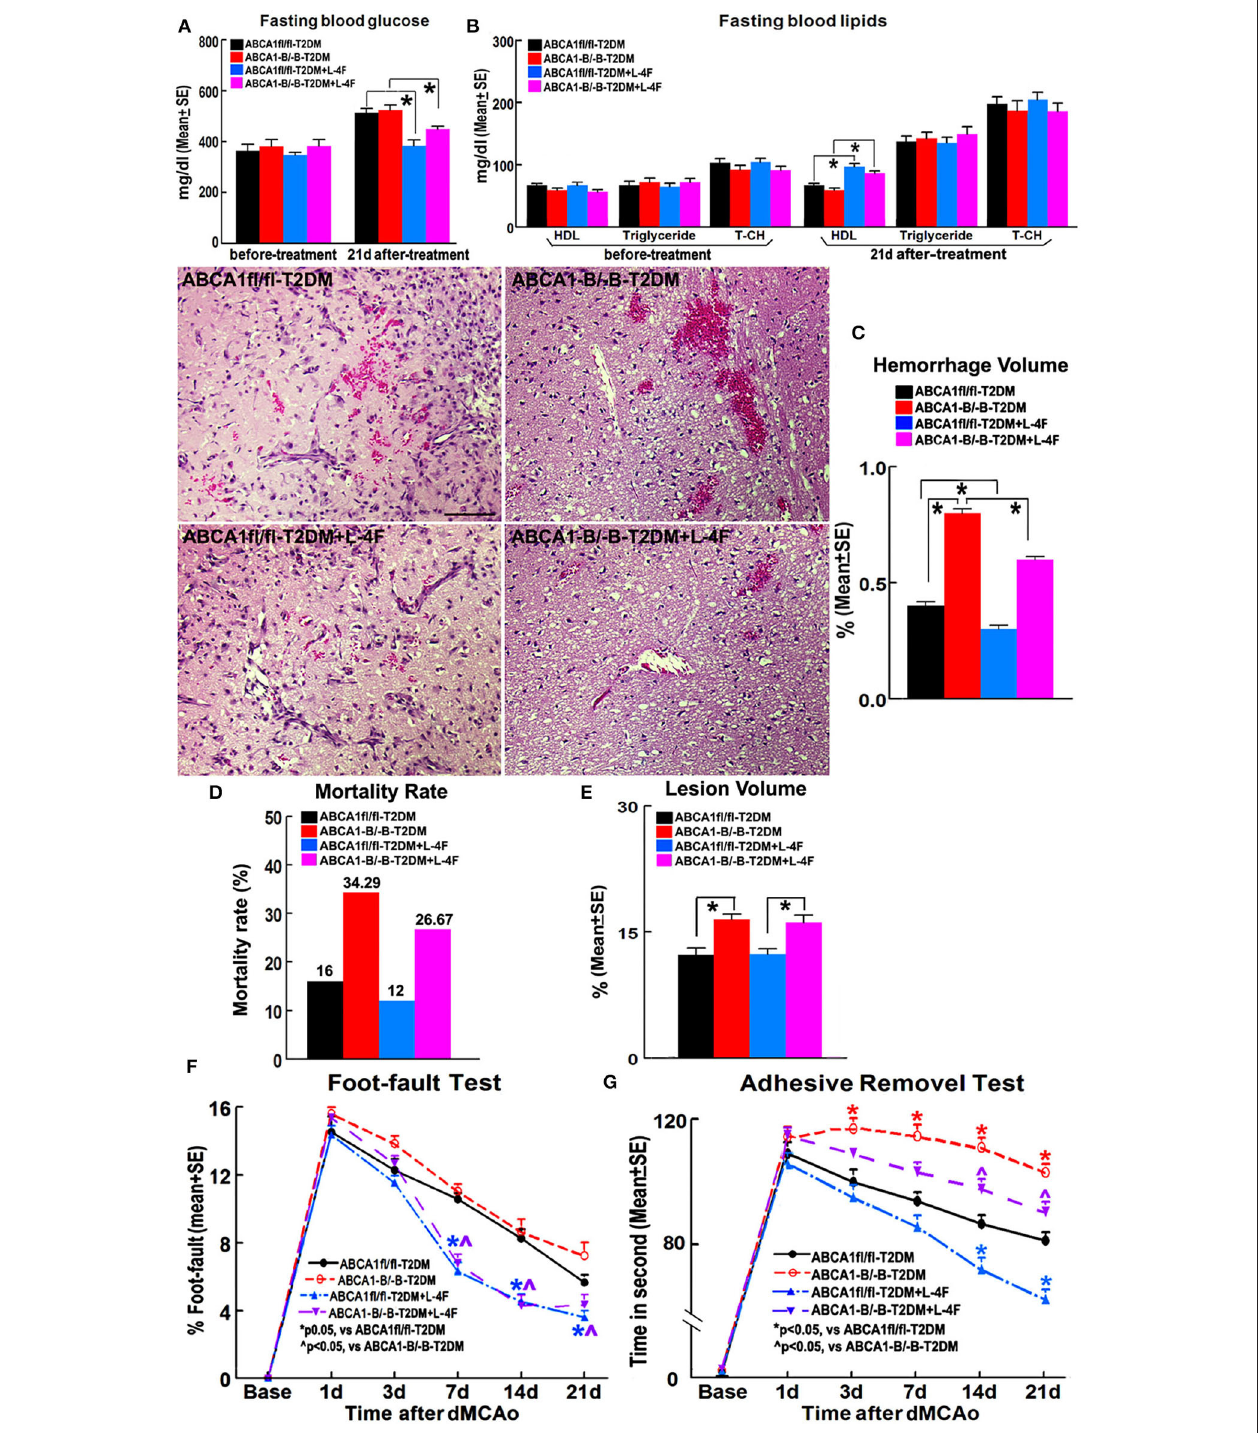
FIGURE 1 | L-4F treatment does not change blood glucose levels before treatment and T-CH and triglyceride after treatment. However, L-4F treatment significantly reduces glucose and increases HDL in the blood 21 days after treatment. L-4F treatment does not alter lesion volume but reduces cerebral hemorrhage and mortality rate as well as improves functional outcome compared with vehicle-control groups in both ABCA1 − B / − B and ABCA1 fl / fl T2DM-stroke mice, respectively. A,B Fasting blood levels of glucose (A) and lipids (B) measured before L-4F treatment at 1 day after dMCAo and 21 days after treatment. p < 0.05, n = 21/group; C–E Cerebral hemorrhage volume (C) , mortality (D) , and lesion volume (E) at 21 days after L-4F treatment. Scale bar = 100 µ m; p < 0.05, n = 9/group; F,G. Foot-fault (F) and adhesive removal (G) tests before dMCAo and 1, 3, 7, 14, and 21 days after dMCAo. * p < 0.05, n = 21/group.